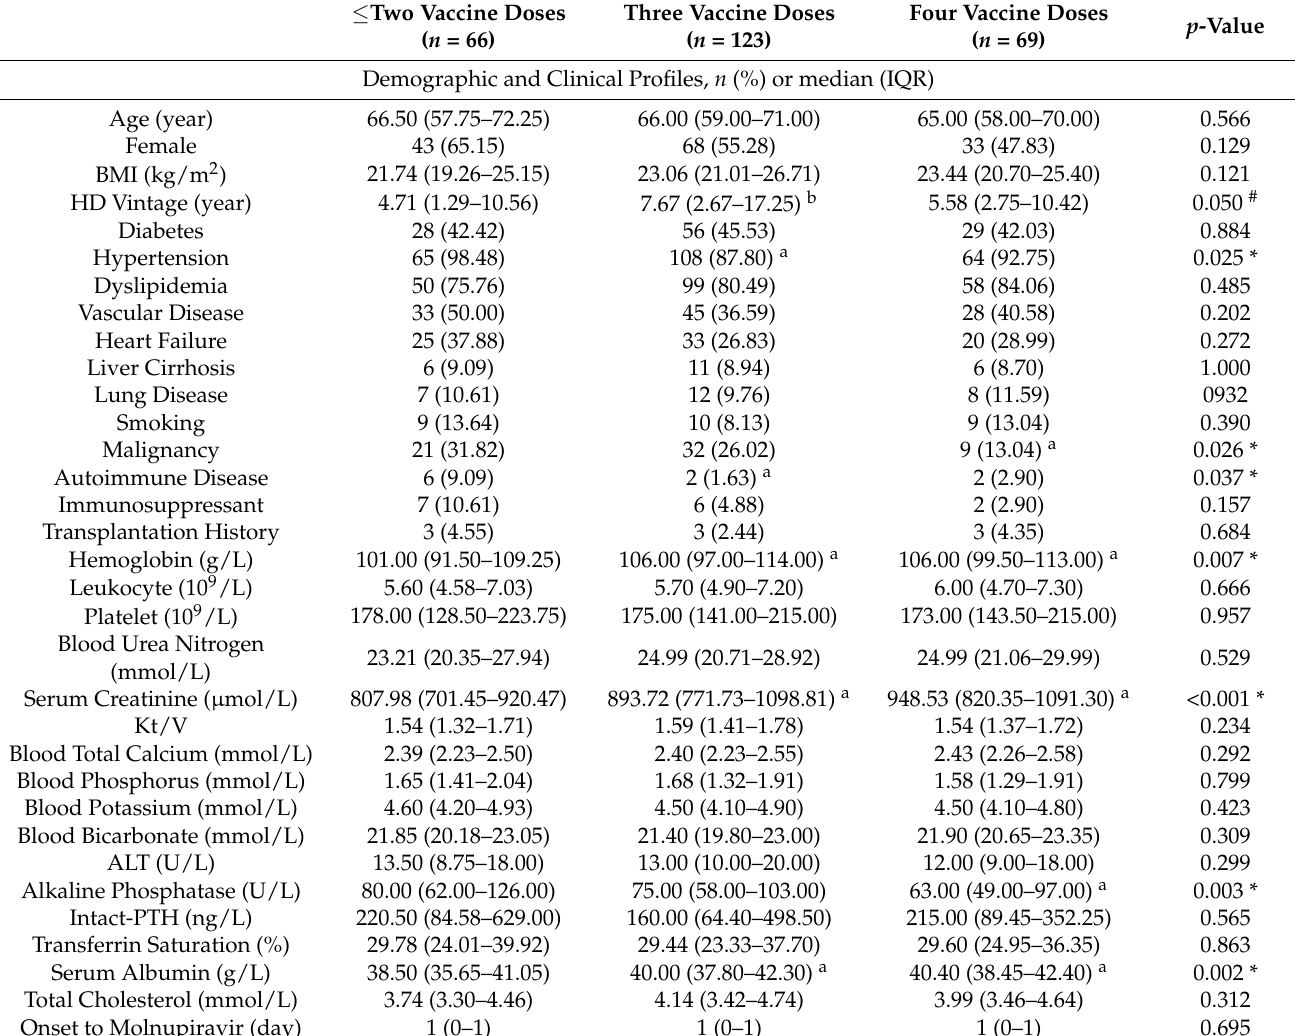
Table 2. Characteristics of HD Patients Who Received ≤ Two, Three, and Four Doses of Vaccination. ≤ Two Vaccine Doses Three Vaccine Doses Four Vaccine Doses p -Value ( n = 66) ( n = 123) ( n = 69) Demographic and Clinical Profiles, n (%) or median